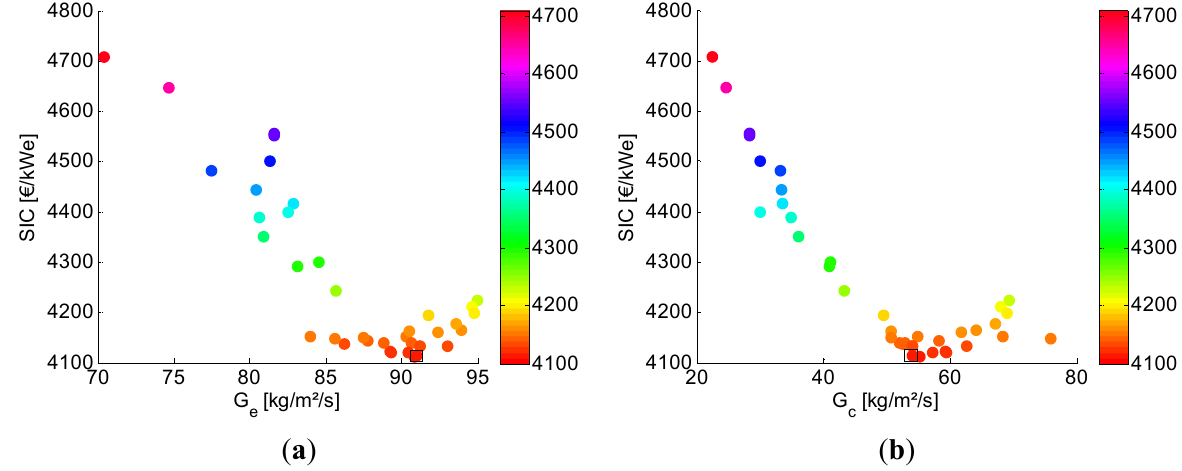
Figure 7. ( a ) Evaporation temperature ( (cid:1846) function of SIC for the SCORC.